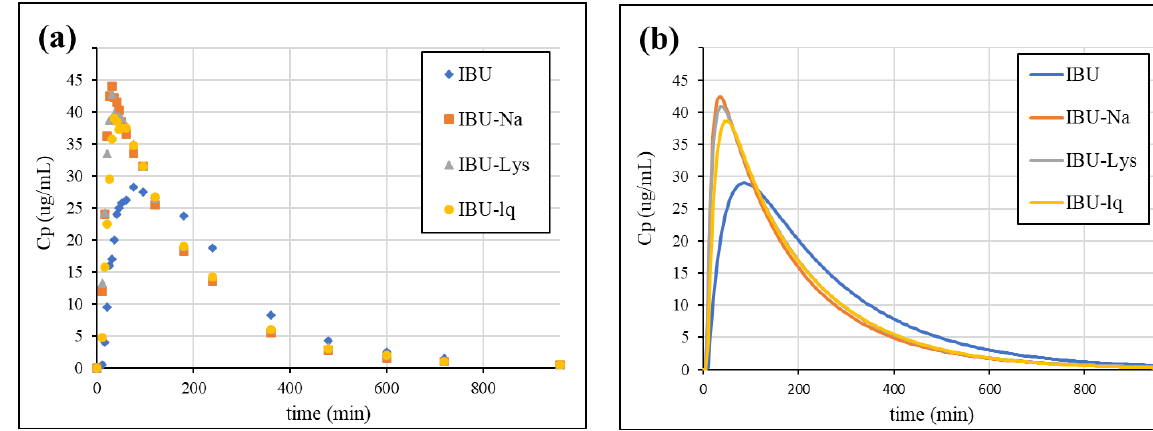
Figure 8. Published plasma concentration profiles ( a ) [23] vs. fitted curves ( b ).